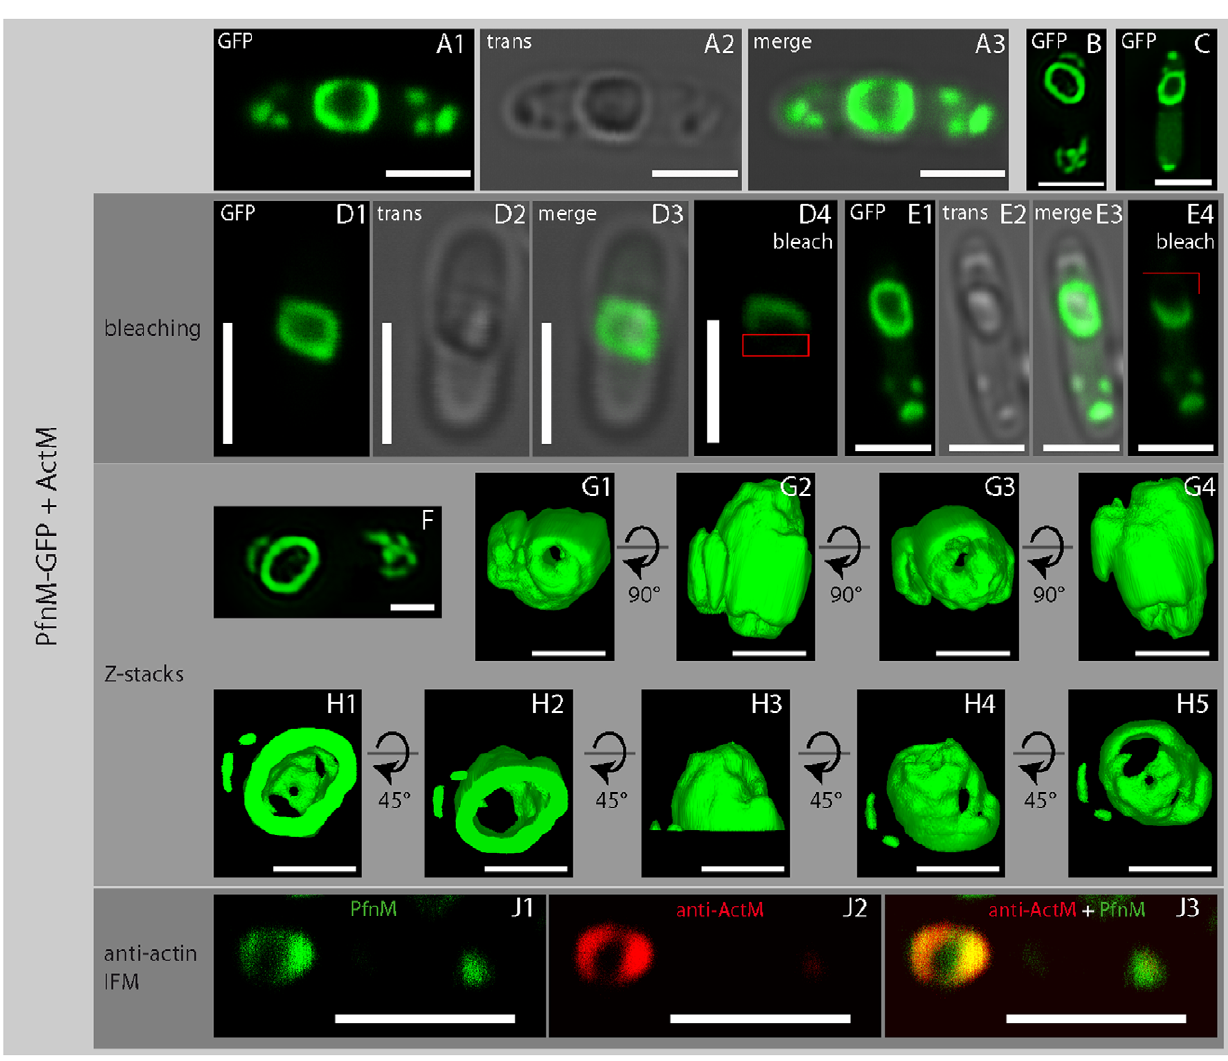
Figure 3. A hollow enclosure in cells co-expressing PfnM-GFP and ActM. Co-expression of PfnM-GFP and ActM gives rise to a hollow compartment. This enclosure is not dynamically rearranged, as fluorescence does not recover 30 minutes after bleaching (D4, E4, the bleached region is indicate by a red rectangle). Z-sectioning and 3D reconstructions of the cell shown in F. Stepwise rotations along the x-axis of the total enclosure (G1-4) or its ‘‘top’’ half (H1-5) is shown. Immunodetection of ActM in the enclosures of E.coli expressing both ActM and PfnM-GFP reveals a co- localization (J1-3). Images show either GFP-channel (‘‘GFP’’), transmission image (‘‘trans’’) or an overlay of both (‘‘merge’’). Scale bars in Z-sectioning and 3D reconstruction: 1 m m. All other scale bars: 2 m m.